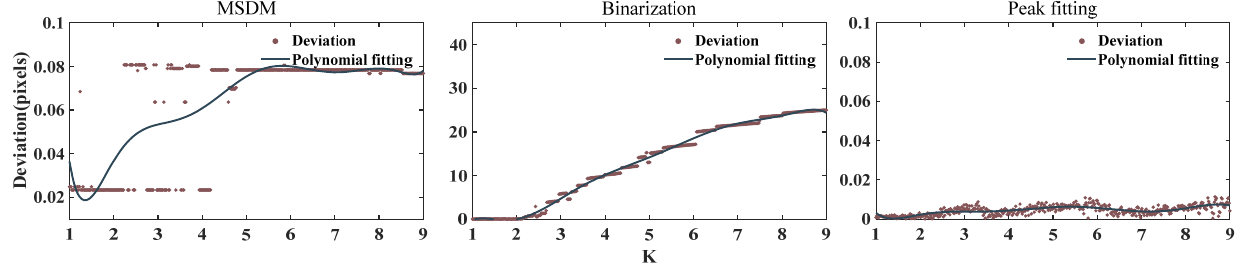
Figure 9. The center deviation using the three algorithms.